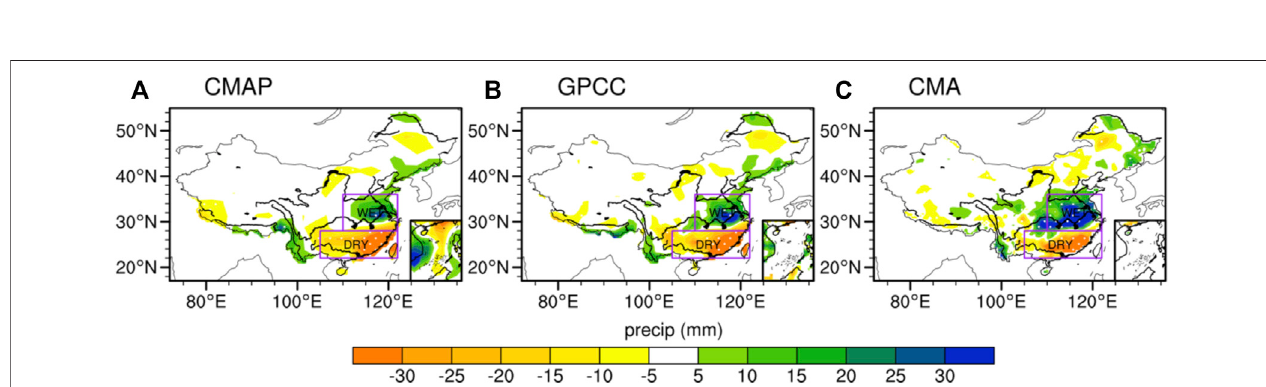
FIGURE 6 | Regression of June rainfall anomalies (units: mm) against the standardized November – December mean Arctic sea ice concentration in Barents – Kara Seas in the preceding early winter. The three rainfall datasets are shown, including (A) CAMP, (B) GPCC, and (C) CMA. The boxes marked are the same as in Figures 2D – F . The dotted regions show the regression at the 95% con fi dence